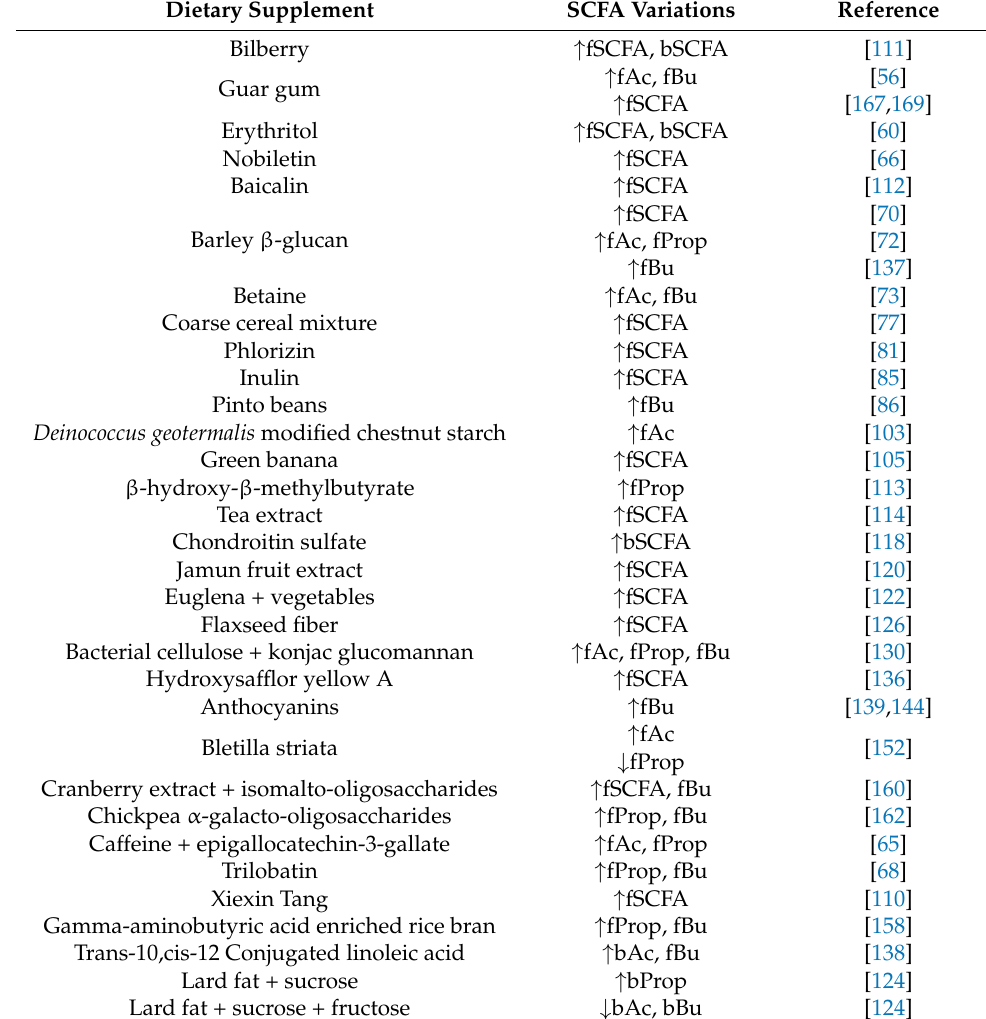
Table 1. Effects on SCFA levels of dietary supplements on HFD-fed mice and